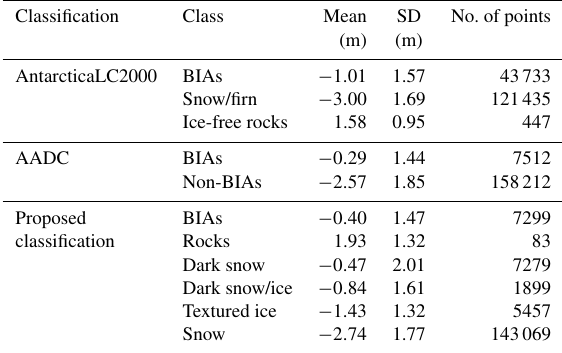
Table 2. Accuracy numbers for height differences of TanDEM-X minus ICESat for different classifications of the southern Prince Charles Mountains (Fig.